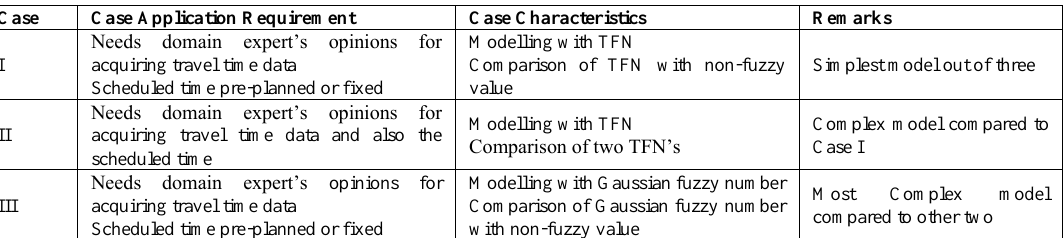
Table 7. Features of the three